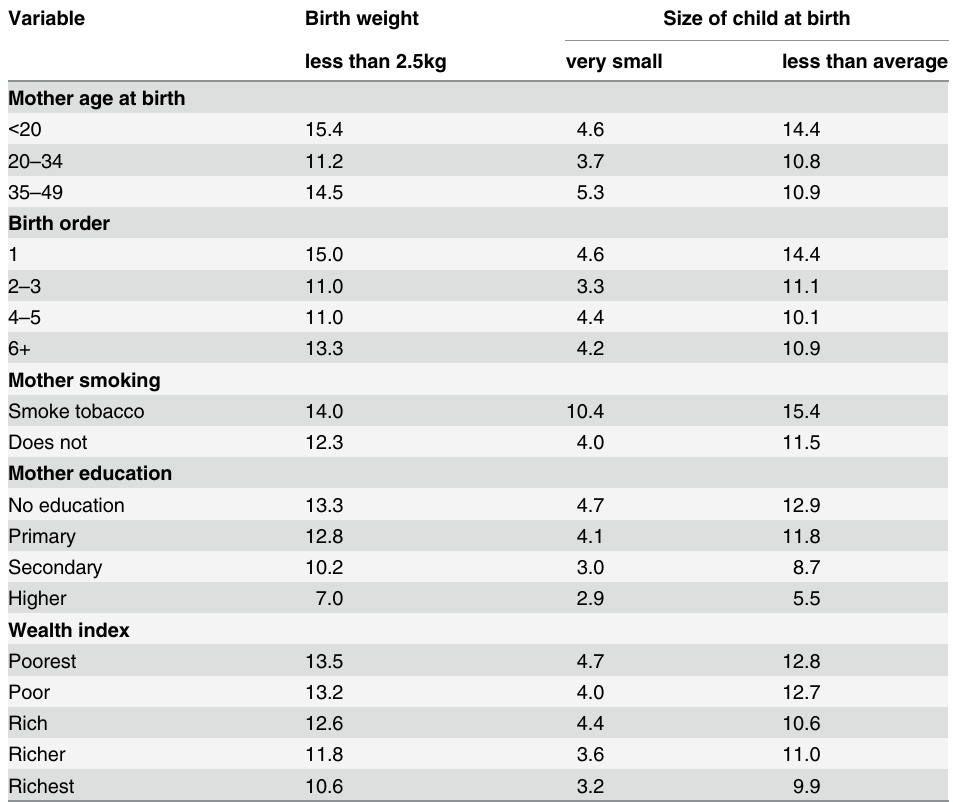
Table 1. Percentage distribution of birth weight and size at birth for some